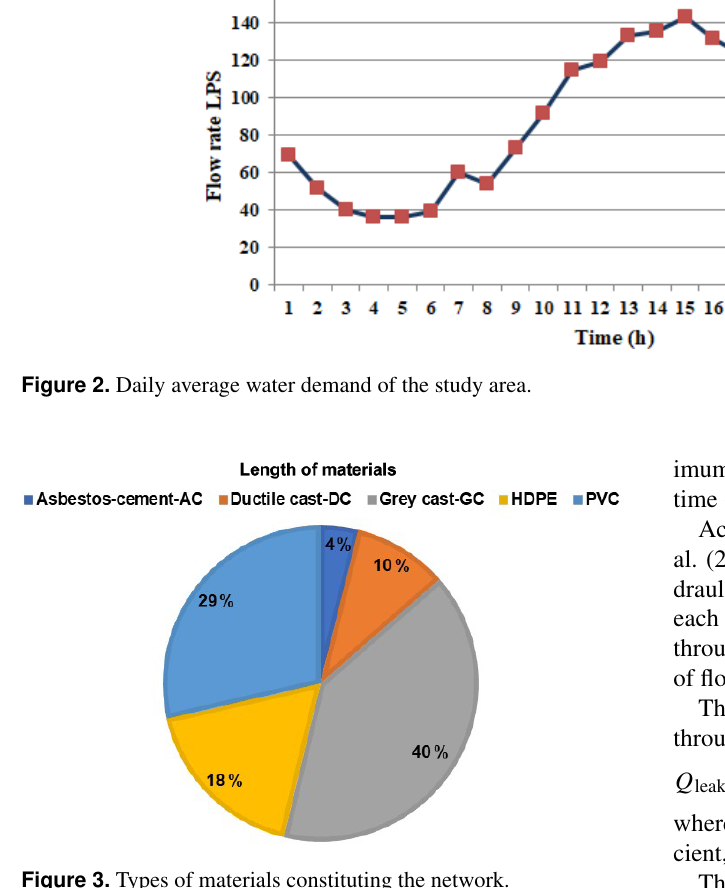
Figure 3. Types of materials constituting the